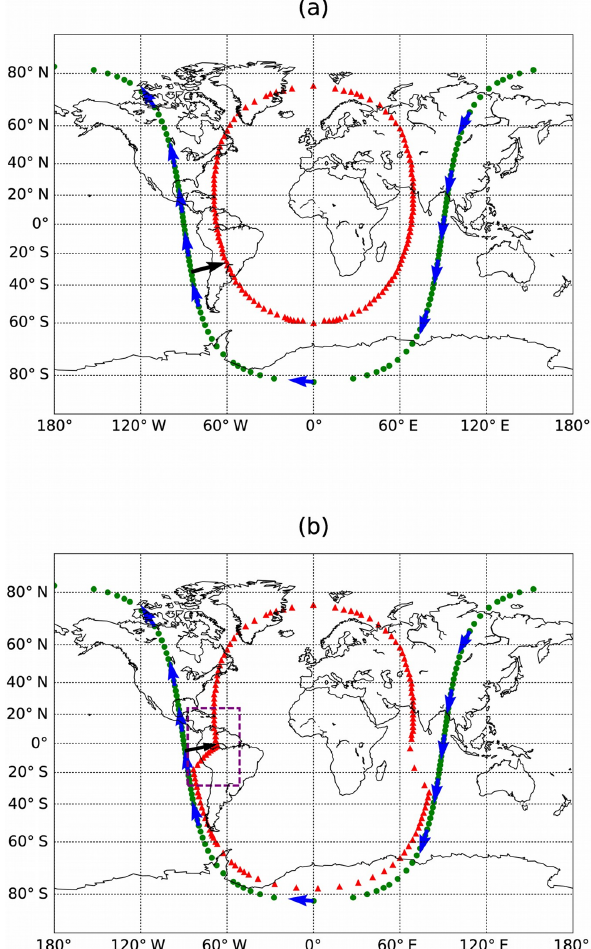
Figure 1. Global observation geometry of an exemplary orbit of (a) conventional limb sounding and (b) sweep-mode limb sounding. The satellite is operated in an orbit at an altitude of 600km and inclination of 98 ◦ . Satellite positions are sampled by green dots and corresponding tangent points by red triangles. The flight direction of the satellite is shown by blue arrows. The viewing direction of the instrument is represented by black arrows. The viewing angle in (a) is perpendicular to the flight direction, while in (b) changes from 10 to 90 ◦ in the ascending orbit, and decreases back to 10 ◦ in the descending orbit. In (b) , the purple-dashed rectangular box represents the region where the sweep mode takes